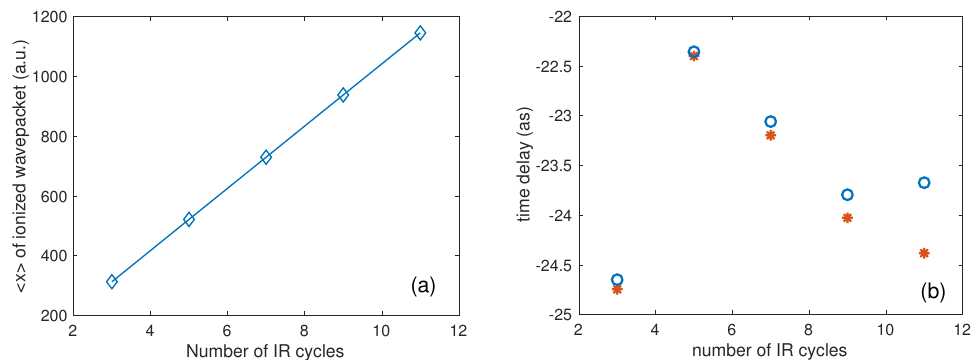
Figure 3. ( a ) Range of wavepacket propagation in an 800 nm streaking pulse after emission at the peak of the pulse as a function of the number of cycles for 1D soft-core model; ( b ) streaking time delay in a potential with additional perturbation (stars) at x 0 = 850 a.u. as compared to the delay obtained without the additional potential (circles) as a function of the number of